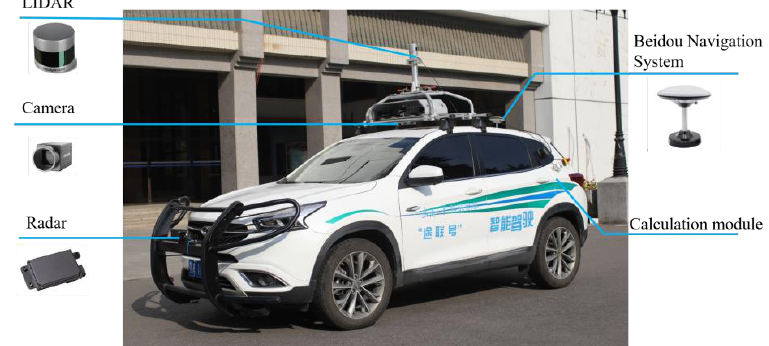
Figure 14. The AV used in our study. Table 5. The main configurations and sensors on our autonomous vehicles.